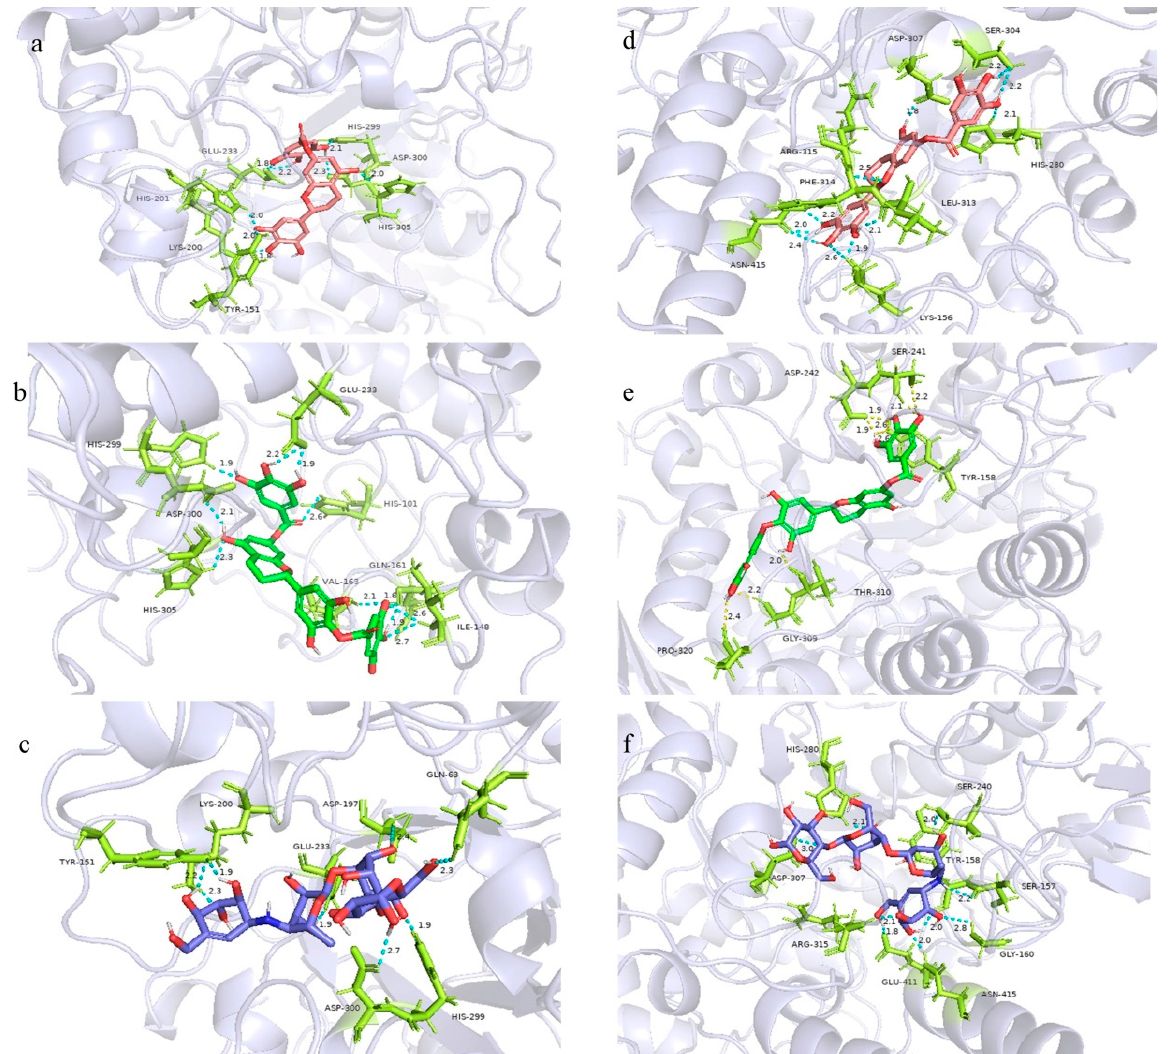
Figure 8. Molecular docking binding site of α -amylase ( a ) 7-O-galloyltricetiflavan; ( b ) 7,4 ′ -di-O-galloyltricetiflavan; ( c ) acarbose; molecular docking binding site of α -glucosidase ( d ) 7-O-galloyltricetiflavan; ( e ) 7,4 ′ -di-O-galloyltricetiflavan; ( f ) acarbose.